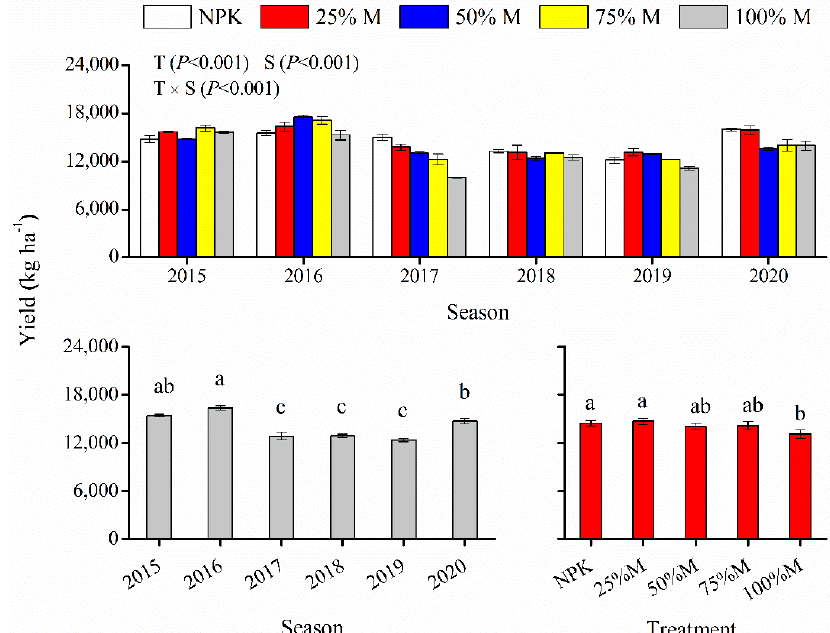
Figure 4. Annual grain yield under different treatments of winter wheat–summer maize cropping system during 2014–2020. Bars represent standard error. Different letters above bars are significantly different between treatments or years at P < 0.05.